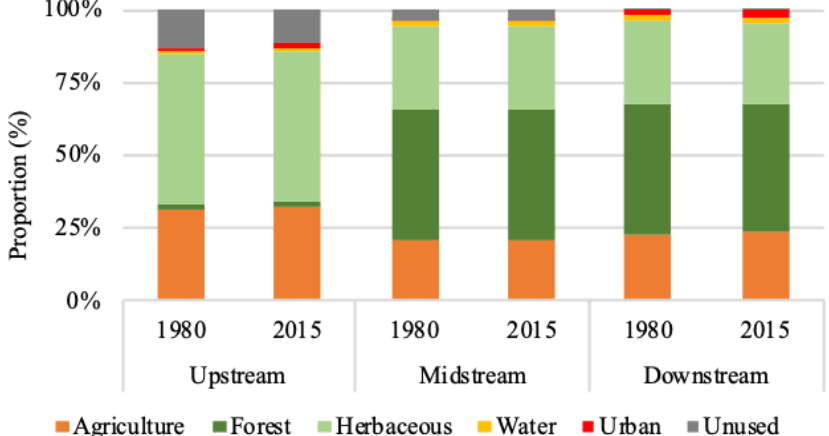
Figure 2. Land use changes from 1980 to 2015 for the different sub-watersheds